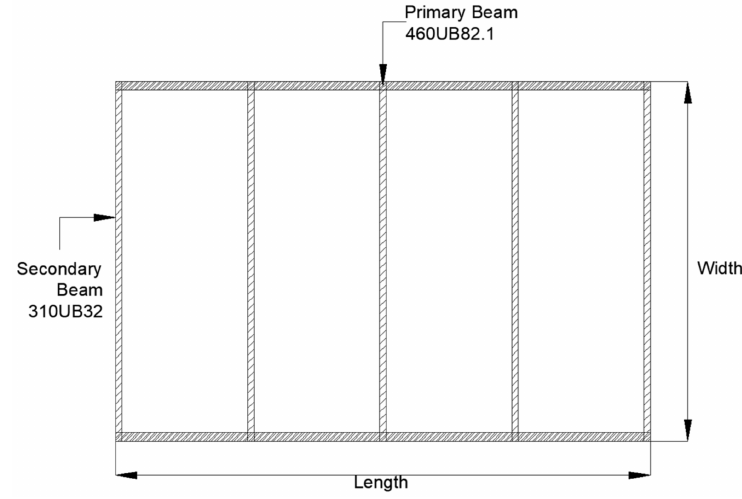
Figure 1. Floor Beam